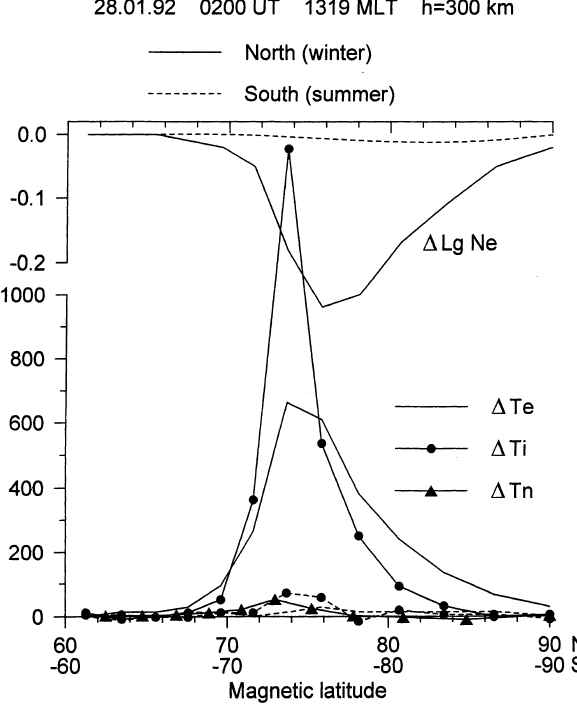
Fig. 9. The calculated disturbances of the electron number density, electron, ion and neutral temperature due to the FACs in the cusp region at height 300 km along the meridian of 1319 MLT at 0200 UT on 28 January, 1992 for the Northern (winter, solid lines ) and Southern (summer, dashed lines ) Hemispheres (variant 2 of